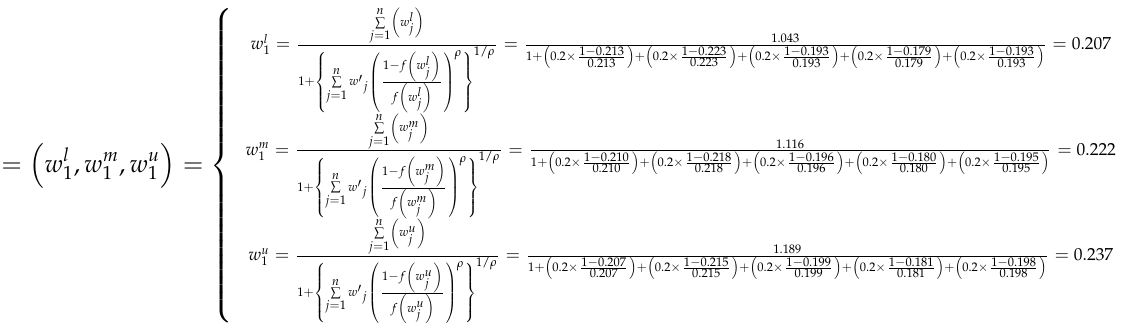
(cid:16) (cid:17) = w l , w m , w u 1 1 1